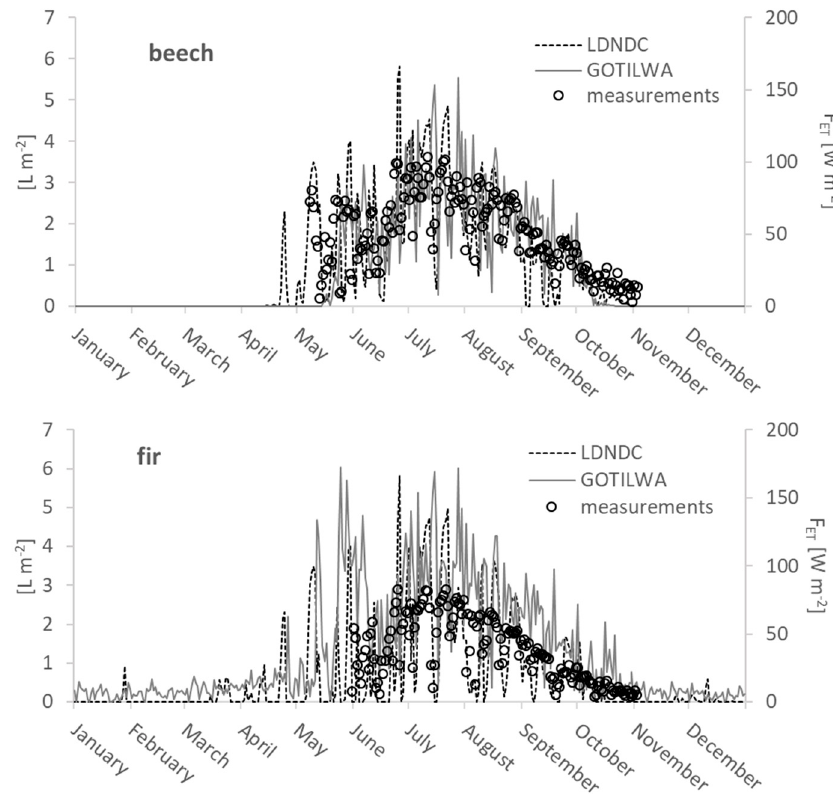
Figure 5. Mean daily transpiration fluxes of beech ( top ) and fir (bottom) calculated with the GOTILWA + and LDNDC for the year 2016 together with averaged measurements from beech and fir trees (in liter per m 2 or mm, respectively (left), and simulated latent heat (F ET ) values (right).